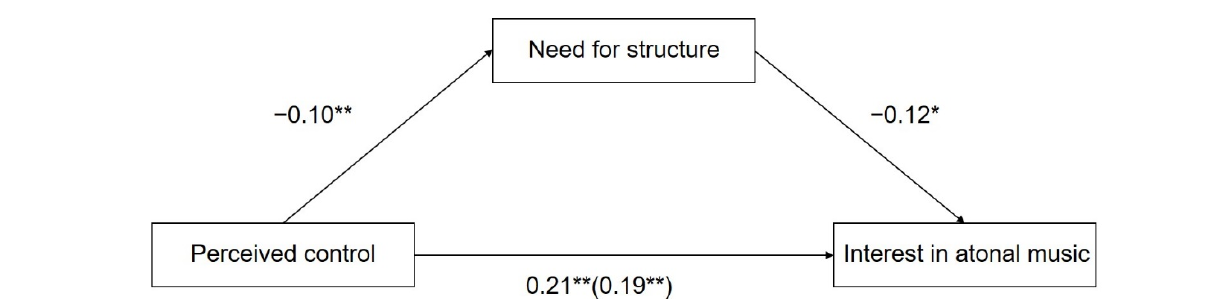
with deviation correction.